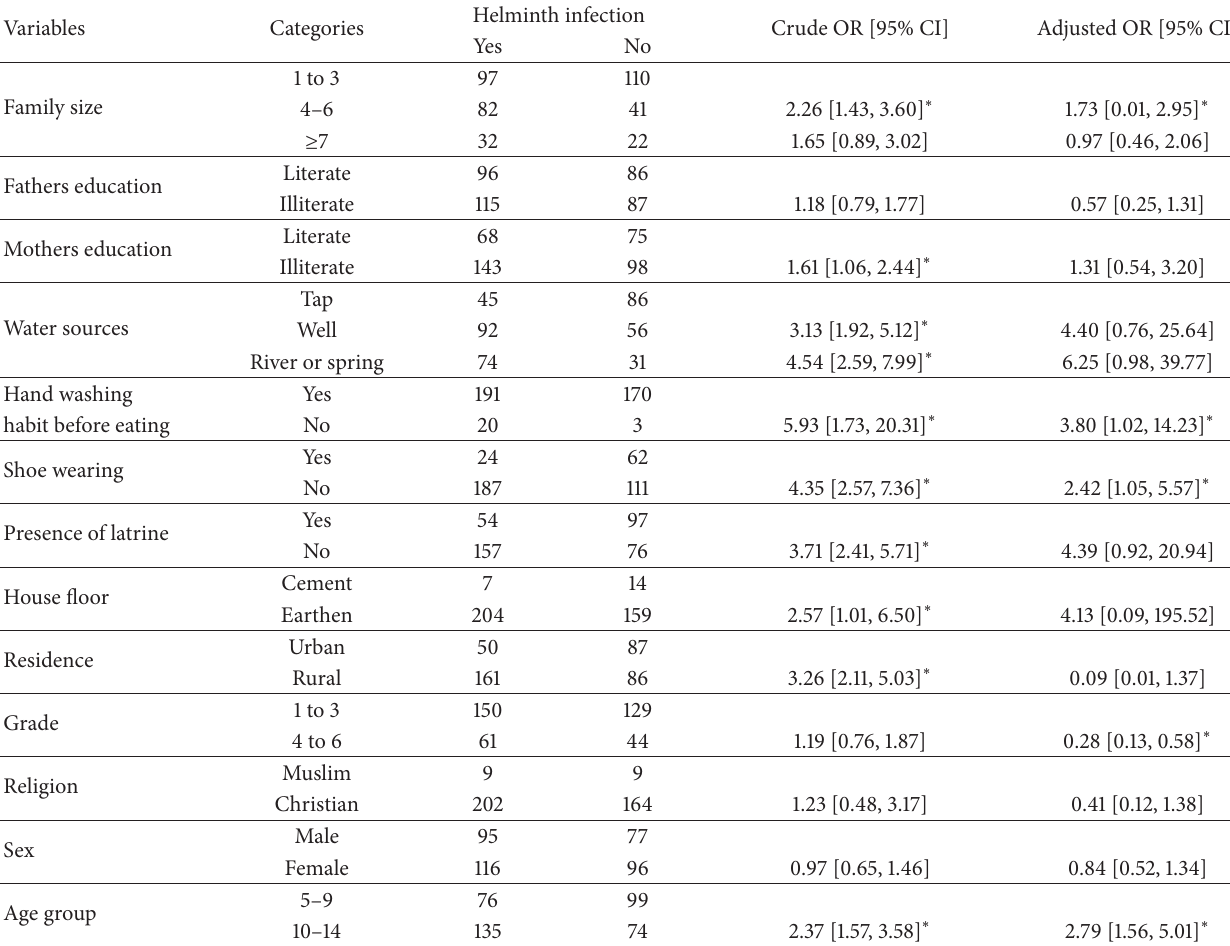
Table 2: Factors associated with soil-transmitted helminth infections among schoolchildren in Abchikeli and Ayalew Mekonnen Elementary Schools, Durbete town, northwestern Ethiopia, February and March